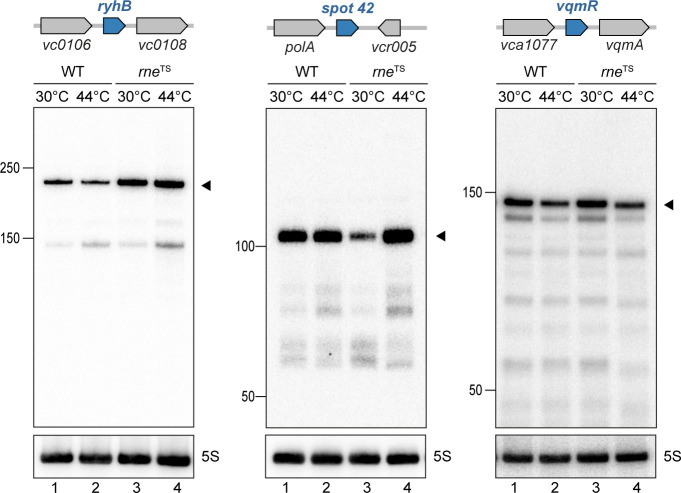
Expression of RNase E-independent sRNAs.V. cholerae wild-type and rneTS strains were grown at 30°C to early exponential phase (OD600 of 0.2; RyhB and Spot 42) or to stationary phase (OD600 of 2.0; VqmR). Cultures were divided in half and continuously grown at either 30°C or 44°C for 30 min. Cleavage patterns of sRNAs without detectable RNase E cleavage sites were monitored on Northern blots. The genomic locations and relative orientations are shown above the gels. Genes are shown in gray; sRNAs are shown in blue. Filled triangles indicate the size of full-length sRNAs. 5S rRNA served as loading control.Figure 1—figure supplement 6—source data 1.Full Northern blot images for the corresponding detail sections shown in Figure 1—figure supplement 6.